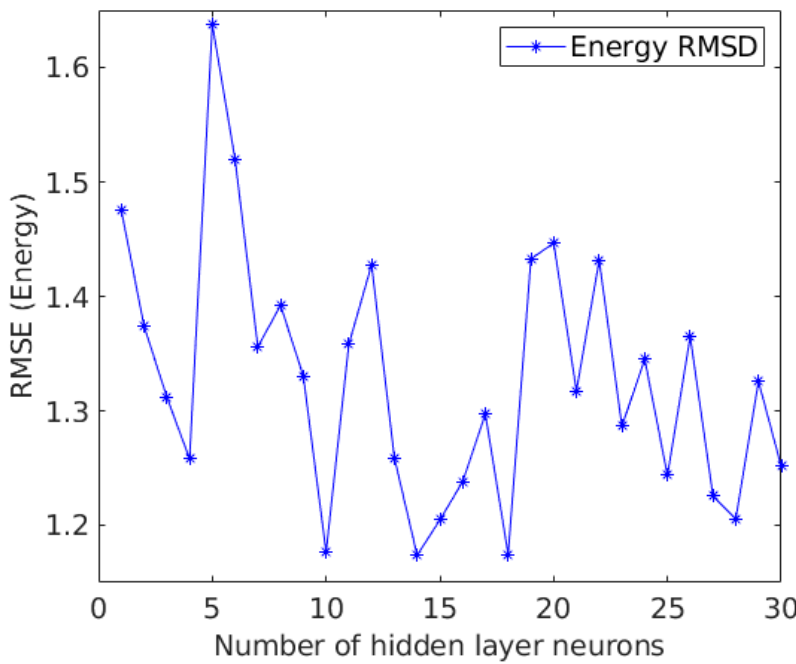
Figure 2. Neural Network Architecture tuning. This analysis was performed with a reduced dataset in order to evaluate the NN performance optimal point.